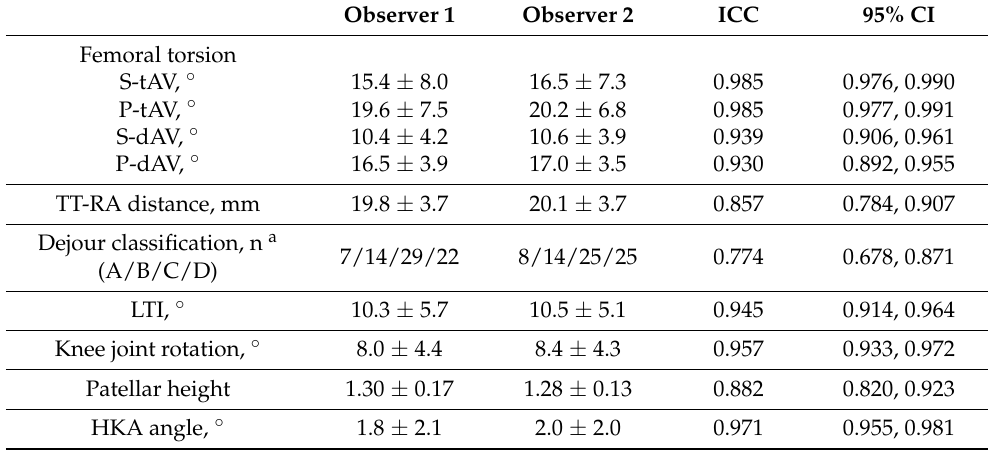
Table 1. Demographic data of the included patients. Variables Number of patients, n 72 Sex, (Female/Male), n 57/15 Age, mean ± SD, y 21.9 ± 8.4 Left 35 Right 37 A/B/C/D 8/15/27/22